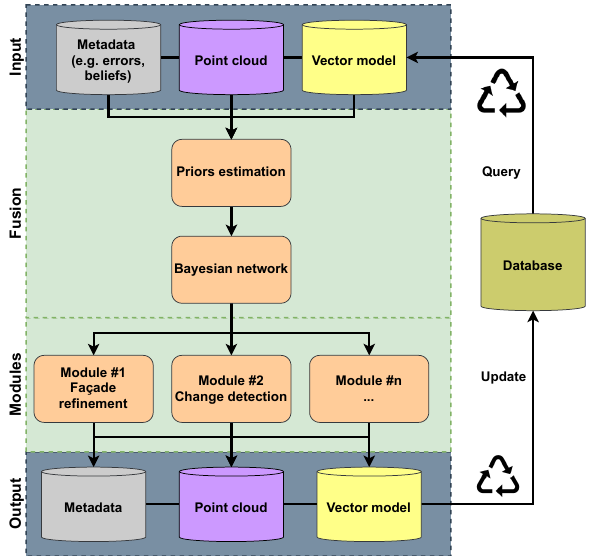
Figure 2. Strategy overview: database (green) query of vector model (yellow), point cloud (purple), and metadata (gray) should trigger the workflow (blueish) and subsequent processes (orange) ultimately leading to the database